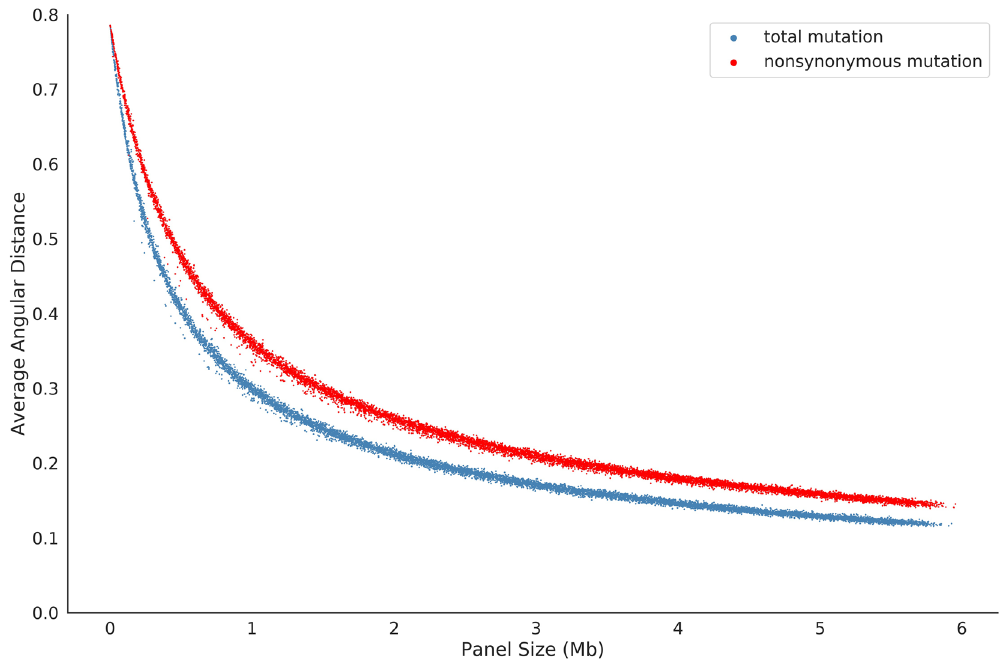
Figure 5. The average angular distance of the simulated sequencing panels in the hypermutation-included dataset using total point mutations (blue) and nonsynonymous mutations (red). The X axis is the size for each simulated panel, and the Y axis is the average angular distance estimated by the simulated panels. The estimation bias is higher when using nonsynonymous mutations as opposed to using total point mutations for the same